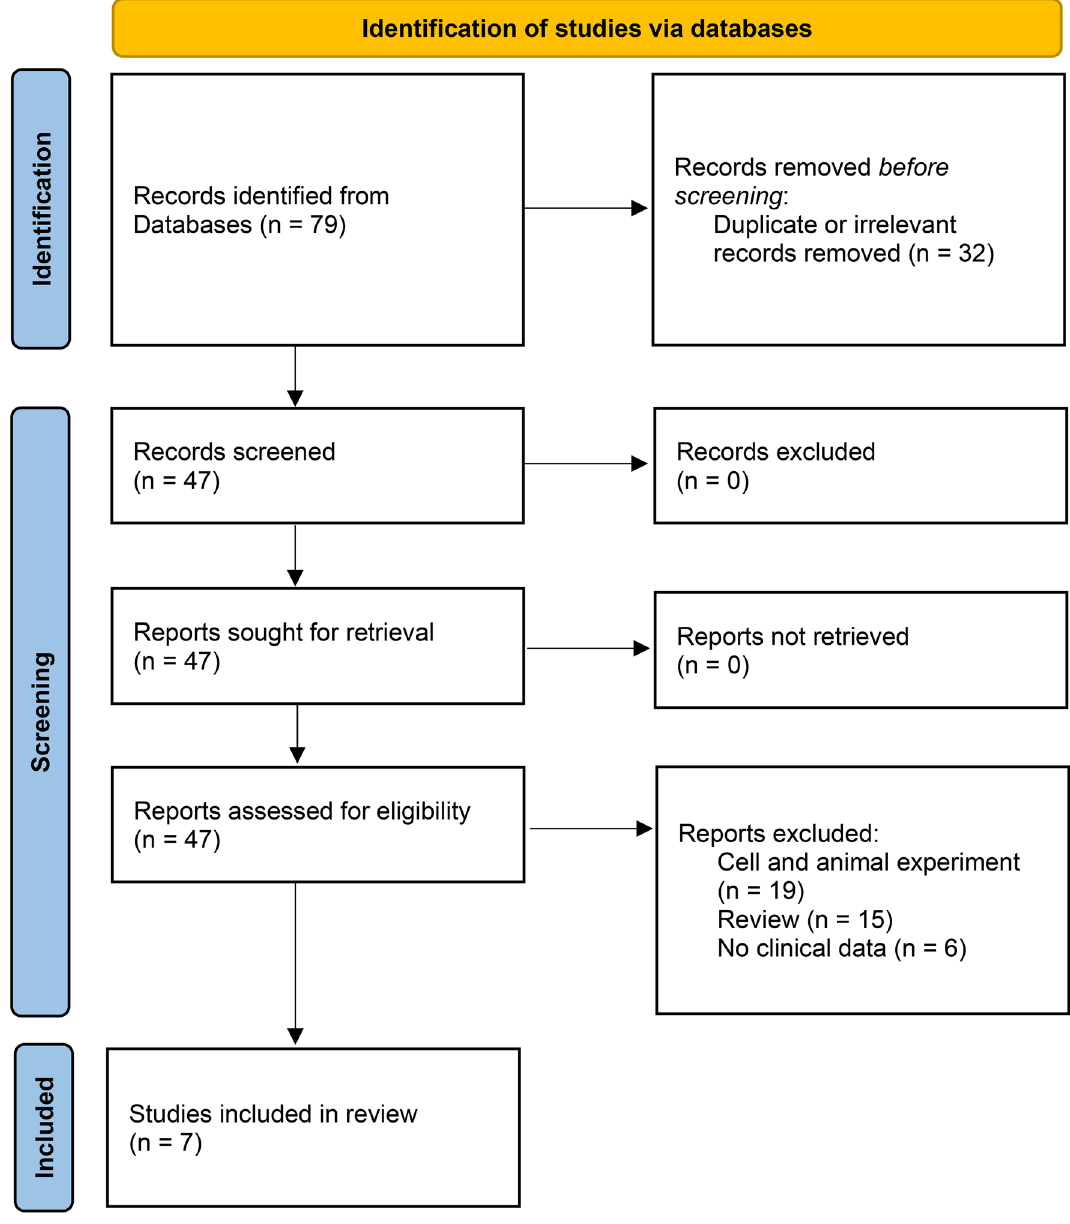
Figure 1. PRISMA 2020 flow diagram of literature